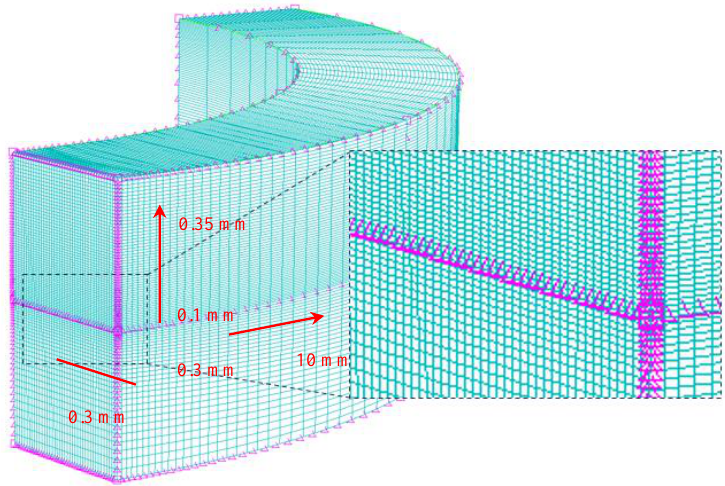
Figure 5. The finite elements mesh on ¼ of the model, with the displayed places of densification with structural hexagonal linear elements.